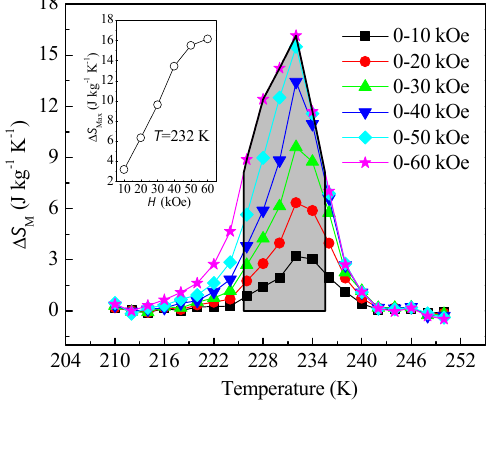
under different magnetic field variations Figure 4. Temperature dependence of the Δ S M ( Δ H ). The shaded area indicates the RC at Δ H = 60 kOe. The inset shows the field dependence of maximum Δ S within the MT temperature range at T = 232 K. M